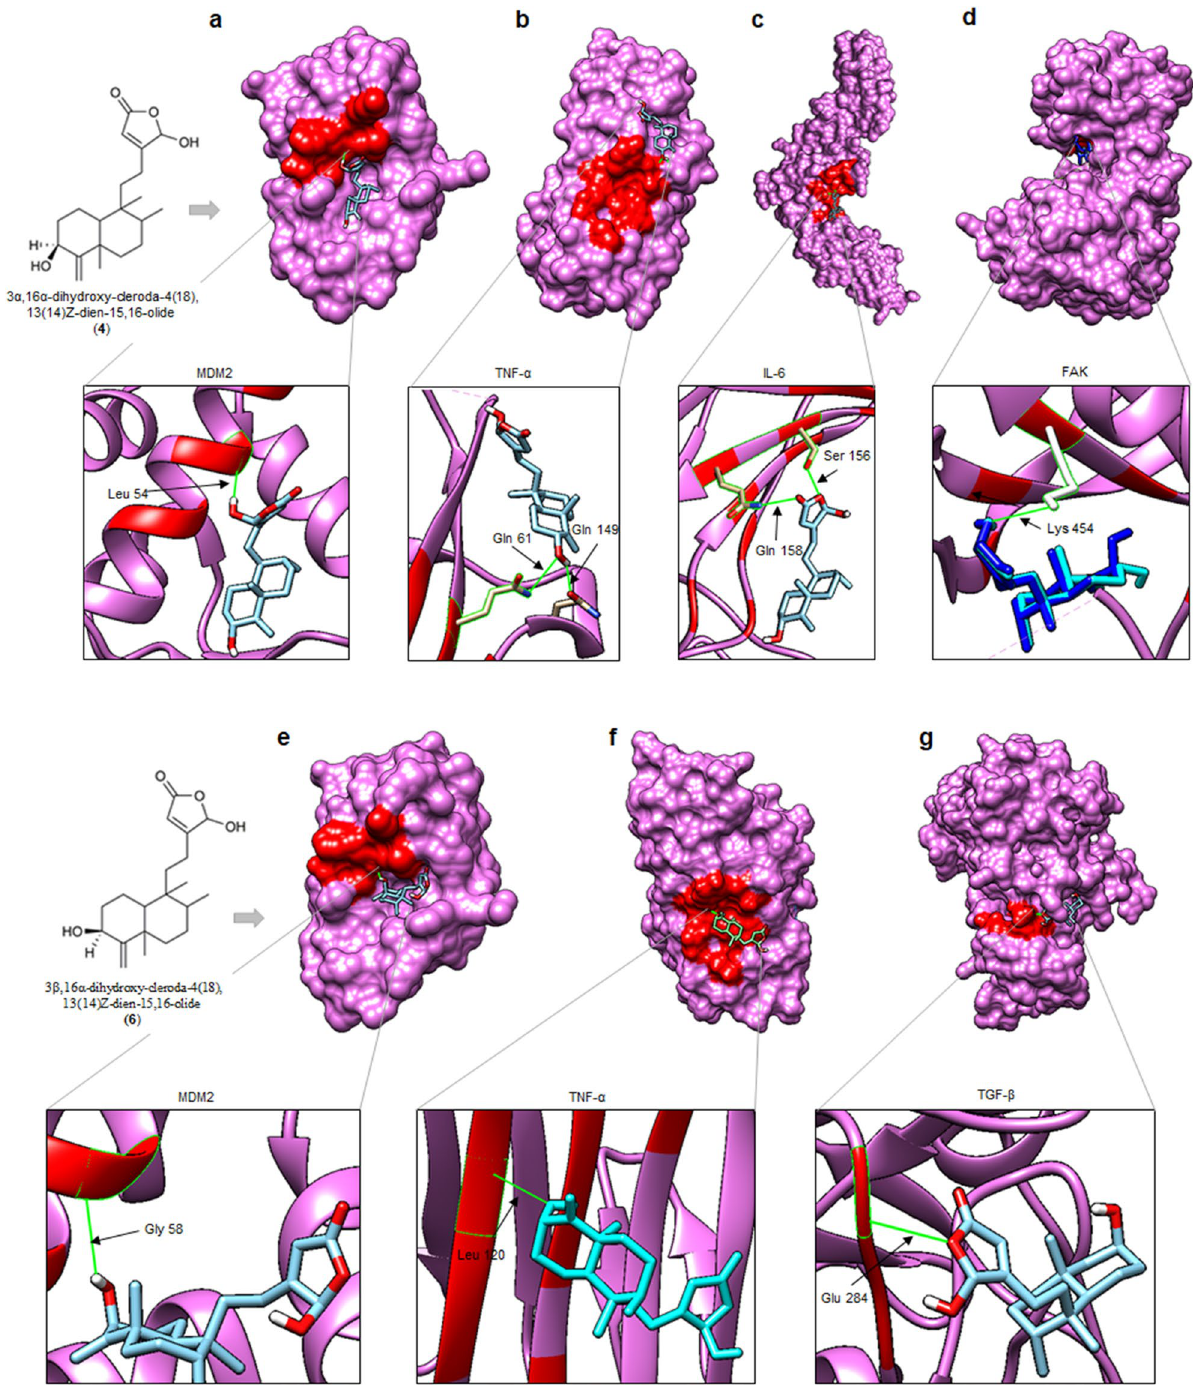
Figure 5. Interaction between compounds 4 and 6 and the target proteins. The 3D interaction and hydrogen bonds between ( a ) 4 -MDM2, ( b ) 4 -TNF-α, ( c ) 4 -IL-6, and ( d ) 4/6 -FAK, ( e ) 6 -MDM2, ( f ) 6 -TNF-α, ( g ) 6 -TGF- β. Hydrogen bond interaction between proteins and ligand shown in green color, and receptor active sites shown in red